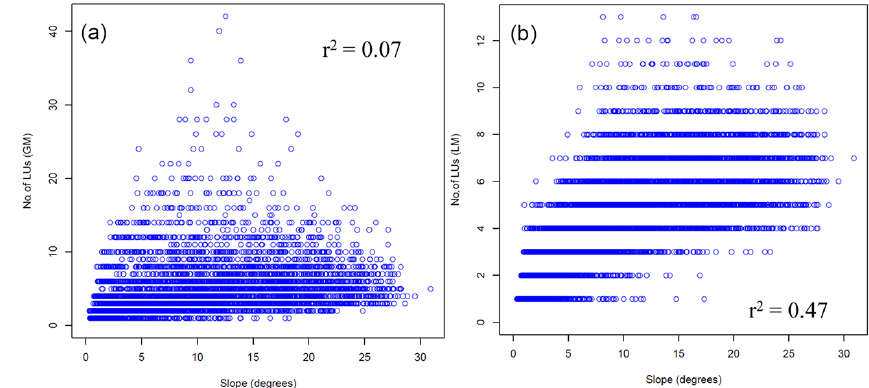
Figure 4. The number of elevation-based geo-located SUs (LUs) plotted against the average topographic slope for each subbasin derived using the global (a) and local (b) methods with 1% area